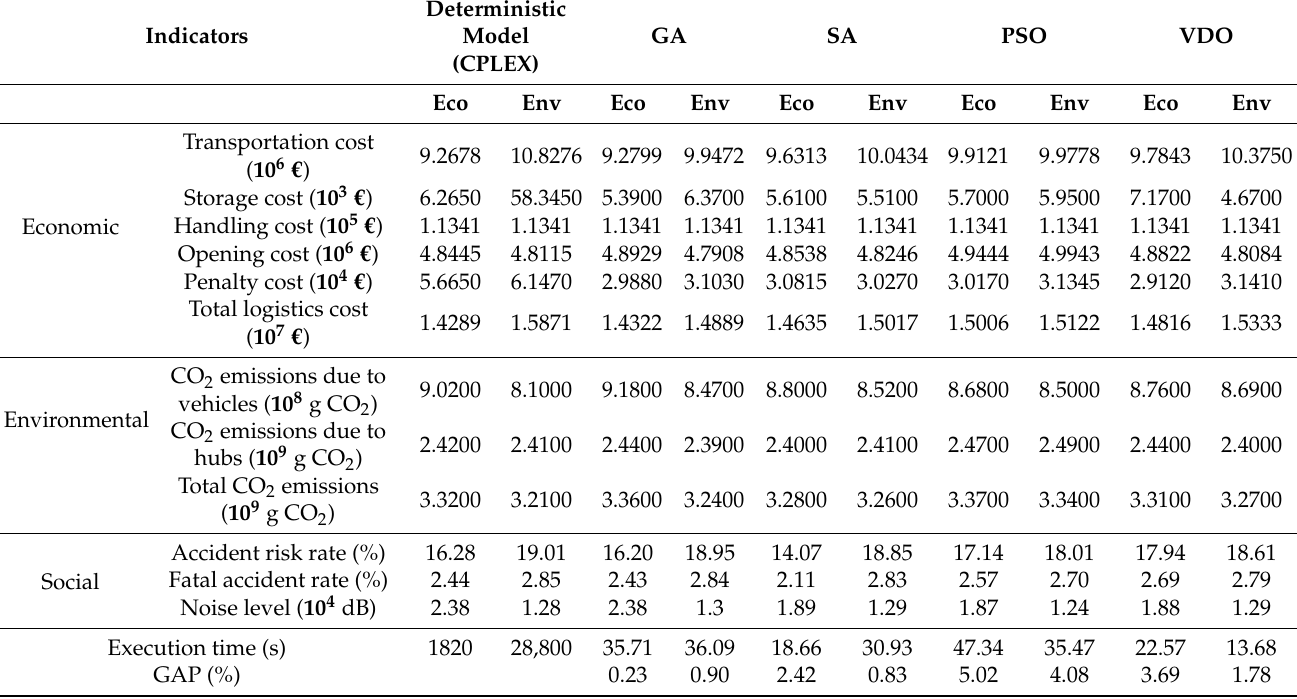
Table A6. Results of Sc1 for the different used